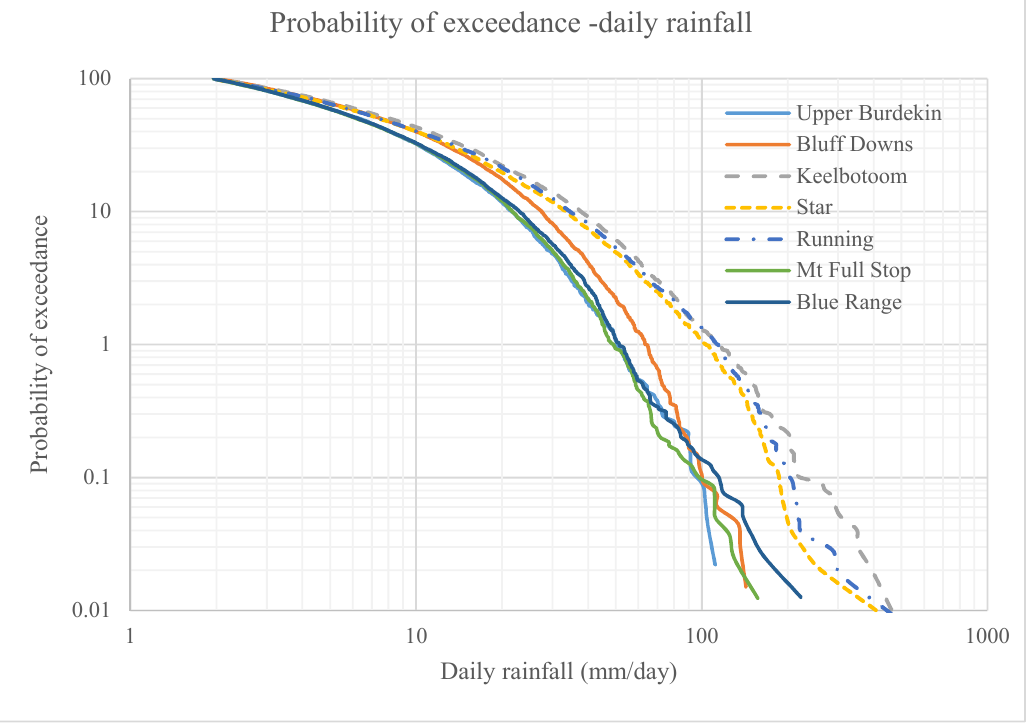
Figure 3. Temporal distribution of the rainfall in Upper Burdekin. Probability of exceedance for daily rainfall data (>2 mm) over seven catchments of Upper Burdekin. Gainsford and Valley of Lagoons catchments are excluded due to shorter data records. Wet (eastern) catchments are presented in dashed-line and drier (western) catchments have continuous lines.